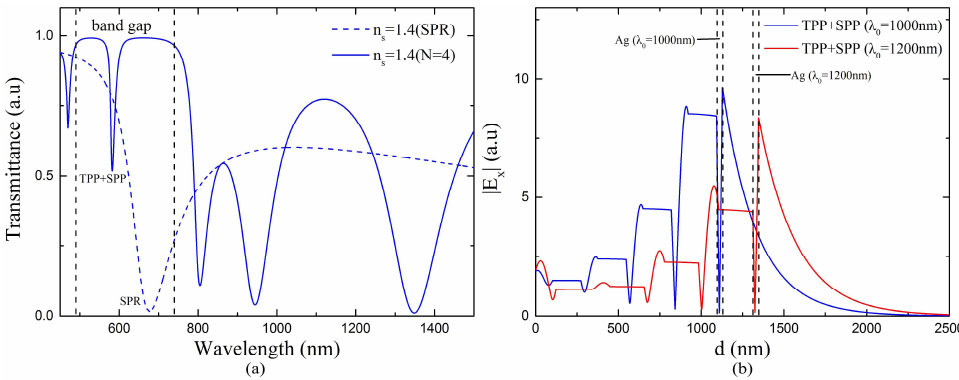
Figure 10. ( a ) Transmission spectrum of the proposed sensor at N = 4, λ 0 = 1200 nm, d m = 35 nm, n s = 1.40. The transmission spectrum of the sensor with a single silver layer of 35 nm is also presented for comparison. ( b ) Tangential electric field distribution of TPP-SPP dip at the resonance wavelength 533 nm and the resonance angle of 87.56 ◦ , 582 nm and 87.45 ◦ for λ 0 = 1000 nm and 1200 nm, respectively.